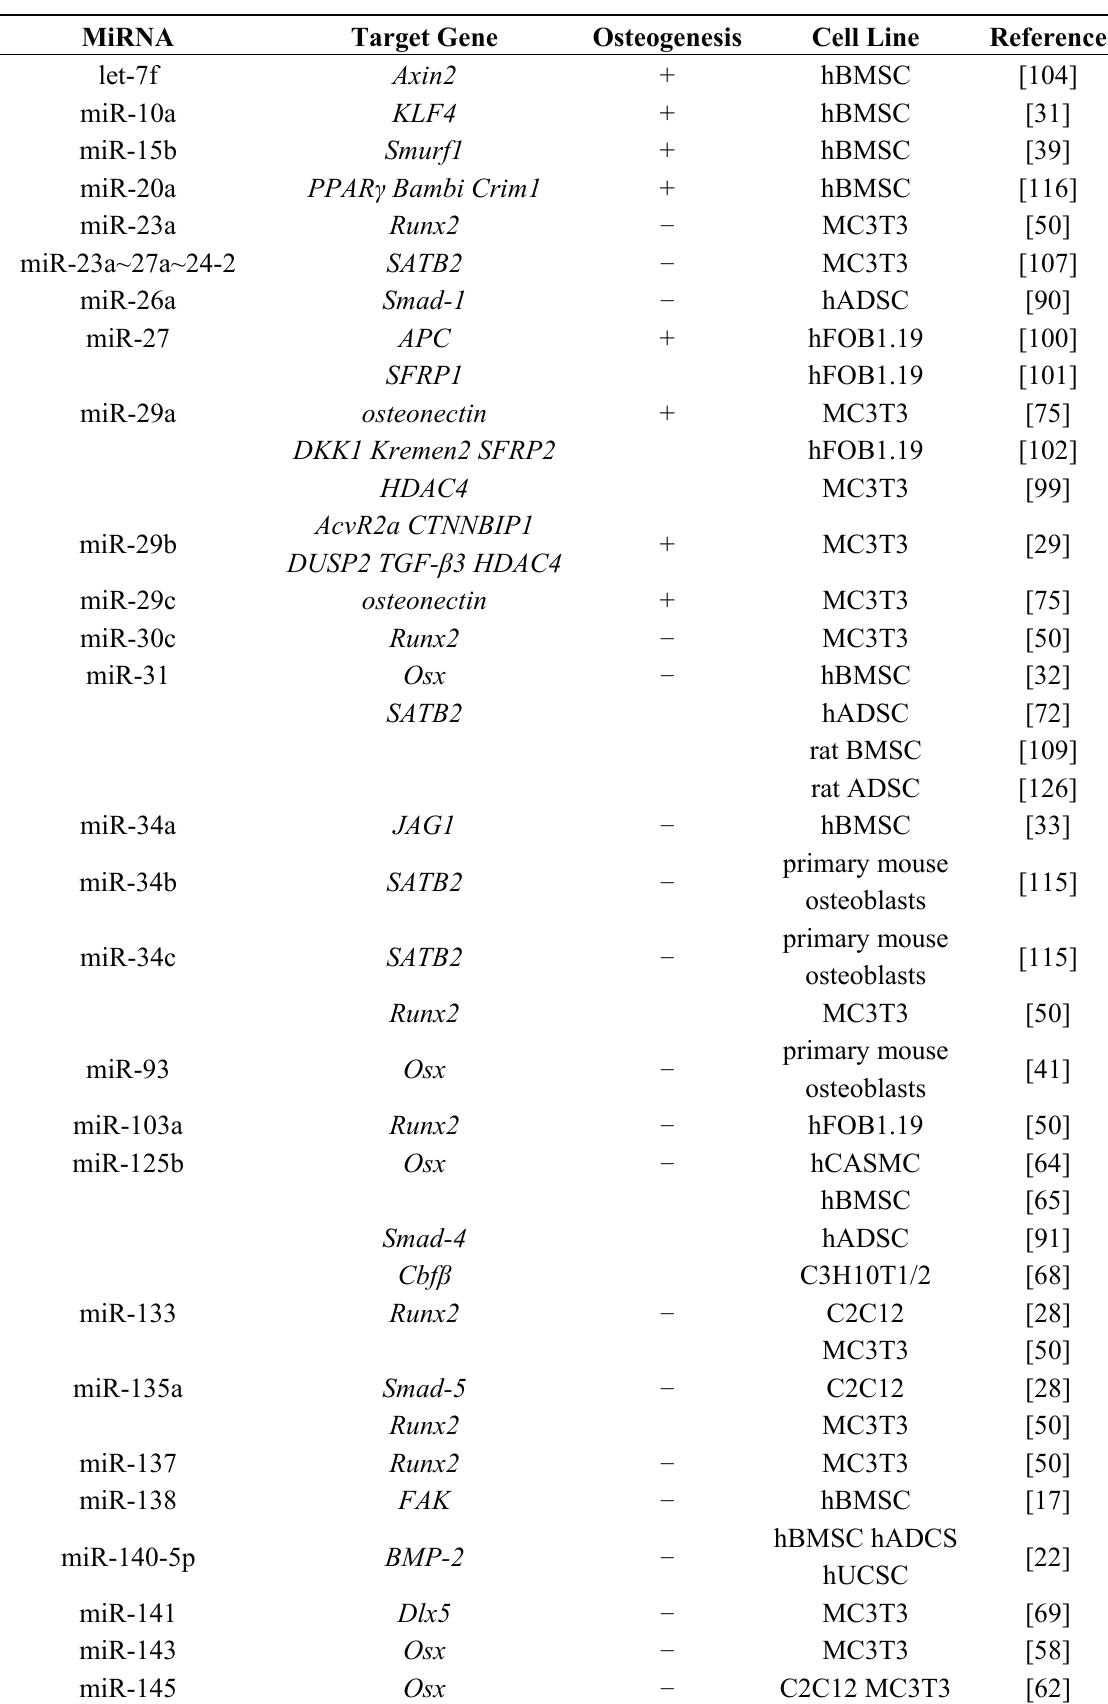
Table 2. MiRNAs in the regulation of osteoblast differentiation. MiRNA Target Gene Osteogenesis Cell Line